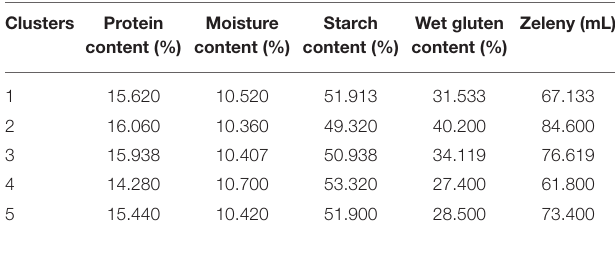
TABLE 7 | Mean values of different quality traits regarding grain nutritional profile of wheat genotypes in cluster analysis. Clusters